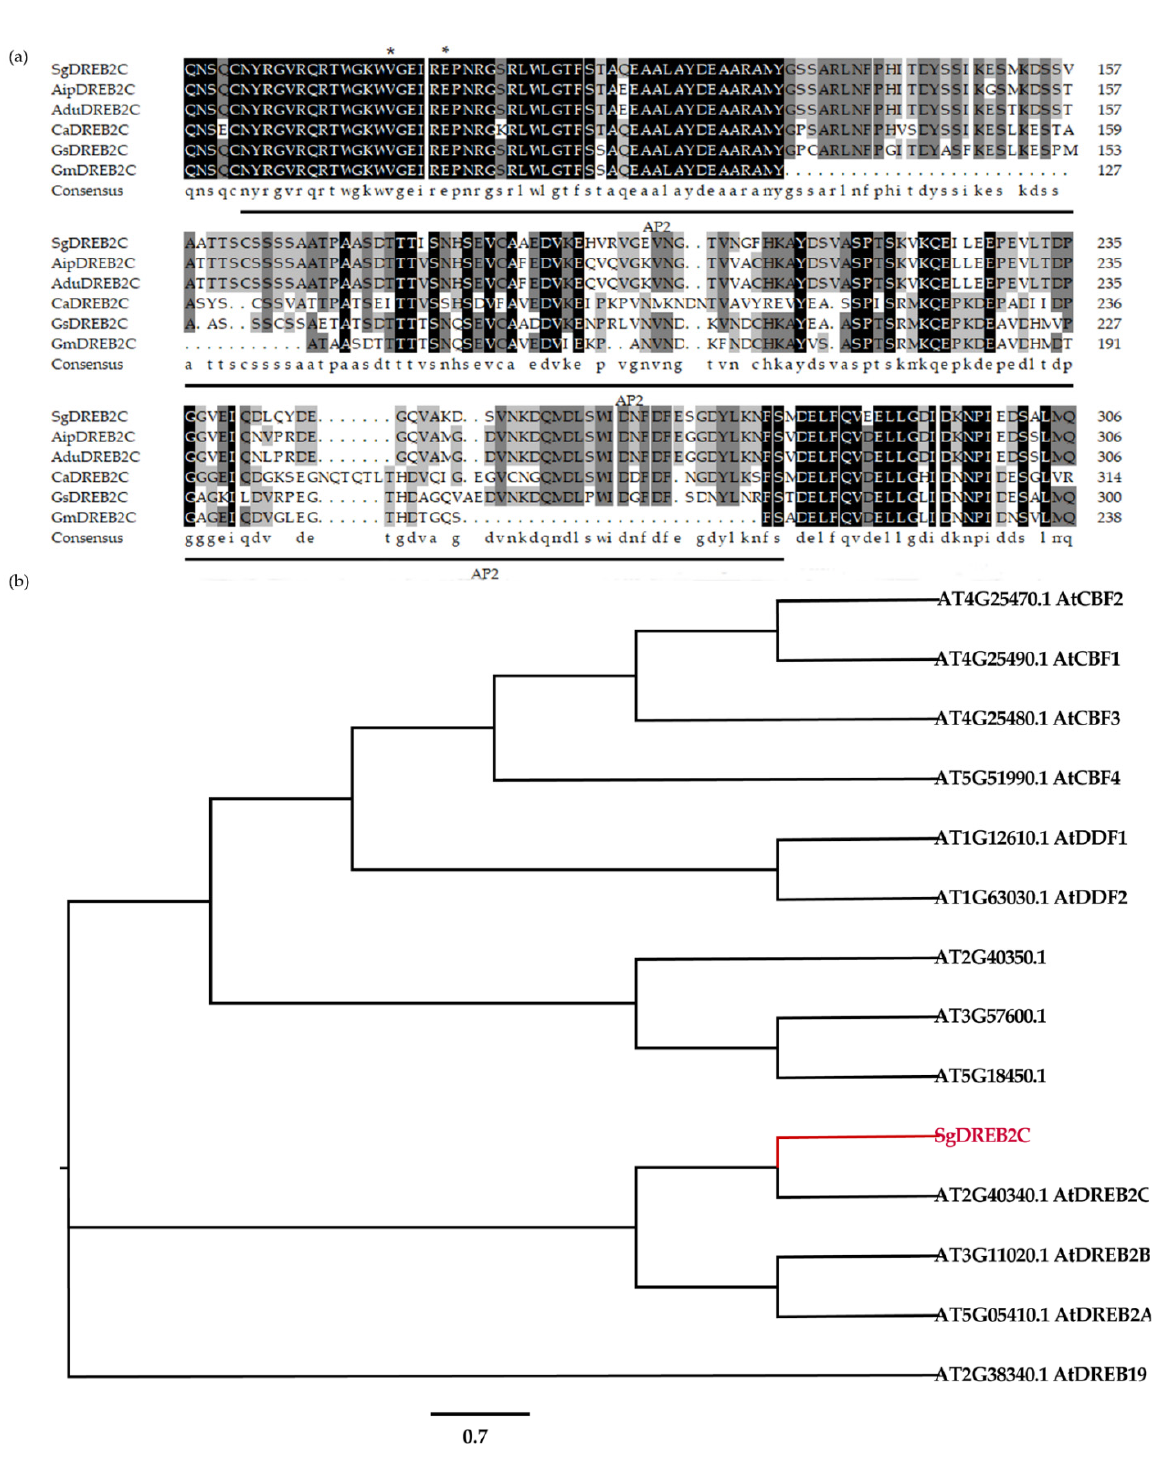
Figure 1. Alignment of multiple sequences and phylogenetic relationships of SgDREB2C and DREBs from A. thaliana . ( a ) Multiple sequence alignment of SgDREB2C and DREBs from other plant species including AipDREB2C (XP_016167062.1) from Arachis ipaensis , AduDREB2C (XP_015973808.1) from Arachis duranensis , AhyDREB2C (XP_025609101.1) from Arachis hypogea , CaDREB2C (XP_004491005.1) from Cicer arietinum , GsDREB2C (XP_028199704.1) from Glycine soja , GmDREB2C (NP_001240005.1) from Glycine max and MtDREB2A (XP_003616701.1) from Medicago truncatula . The asterisks (*) represent the conserved amino acid. ( b ) Phylogenetic tree analysis of SgDREB2C with other DREBs from different subgroups in A. thaliana